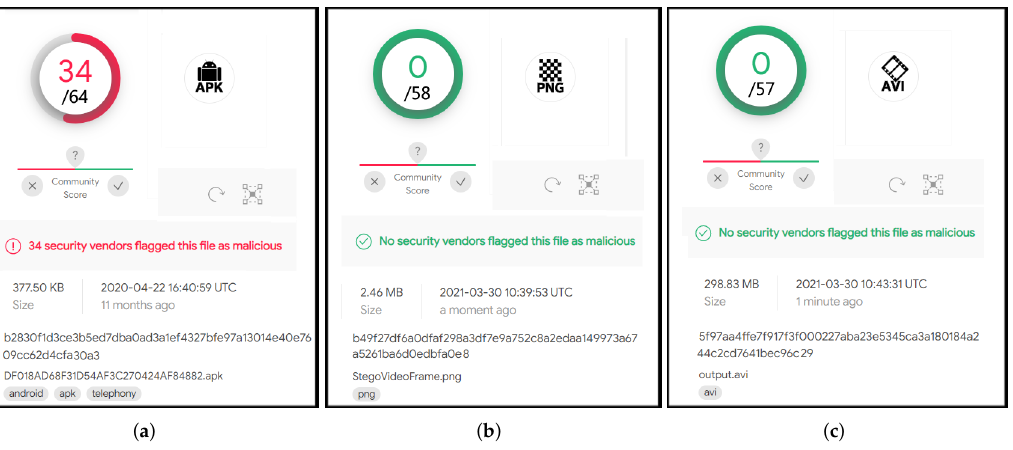
Figure 2. VirusTotal scanning results. ( a ) Ransomware scan result. ( b ) Stego frame scan result. ( c ) Infected video scan